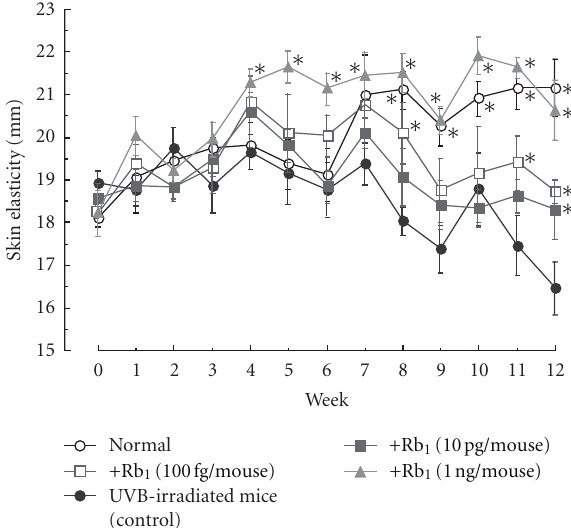
Figure 10: E ff ects of ginsenoside Rb 1 on skin elasticity in chronic UVB-irradiated male hairless (HRM-1) mice [31]. The experiments were performed as described in Figure 9. The dorsal skin was lifted up and skin stretch was measured using a digimatic caliper. Skin elasticity after UVB irradiation was measured every week. Values are the mean ± SE for 6 mice. ∗ Significantly di ff erent from vehicle- treated mice, P < 0 .